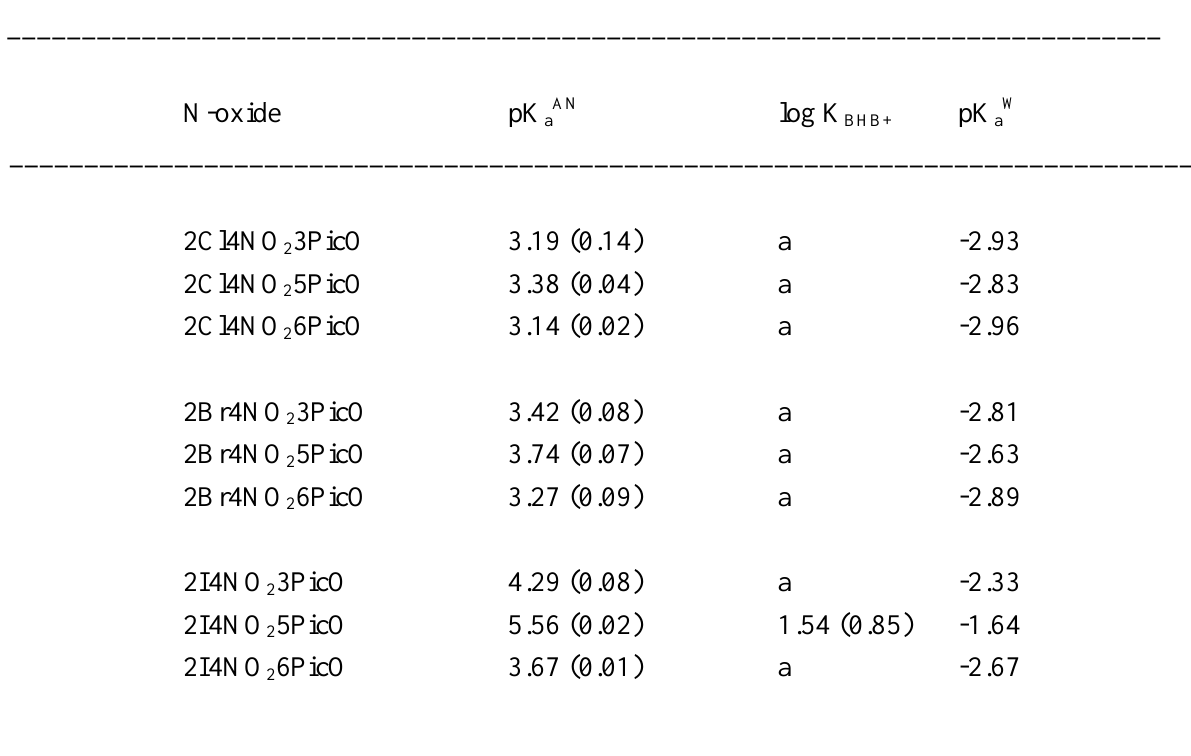
Table 2. Acid dissociation constants, pK aAN , and cationic homoconjugation constants, logK halo-4-nitropicoline N-oxides determined in acetonitrile at 298 K, and those estimated from correlation (3) of the pK aW values in